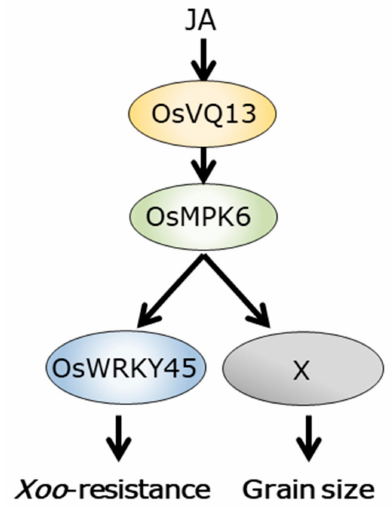
Figure 7. A model for OsVQ13 / OsMPK6 complex-mediated signaling pathways in rice. OsVQ13 associates with OsMPK6 and acts as an activator of the OsWRKY45-dependent signaling pathway, contributing to resistance to Xanthomonas oryzae pv. oryzae . OsVQ13 also a ff ects rice grain development by associating with